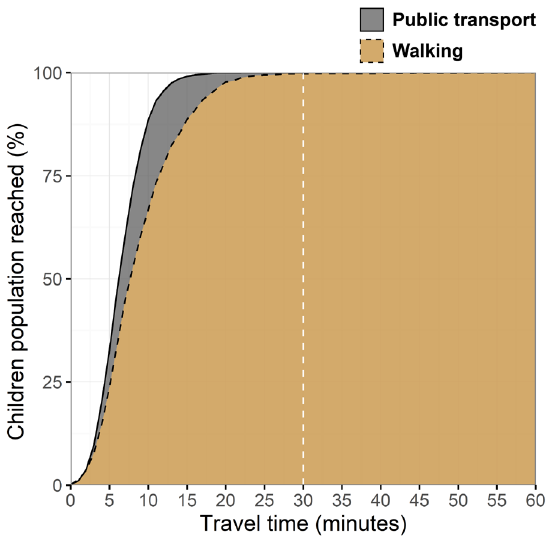
Fig. 5. Travel time accessibility to the closest naturally frozen ice skating fields for children and adolescents in Helsinki. The threshold of 30 minutes is shown with a white dashed